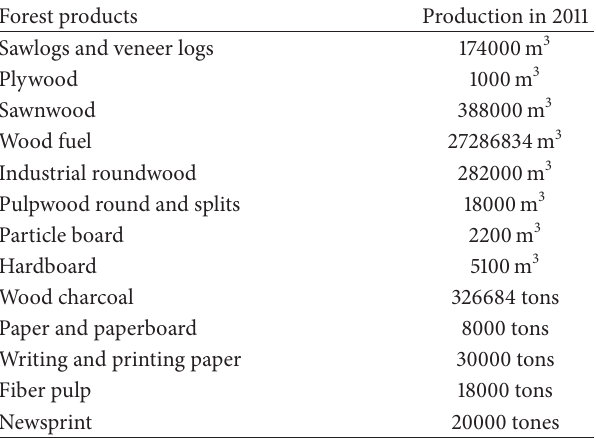
Table 5: Forests products in